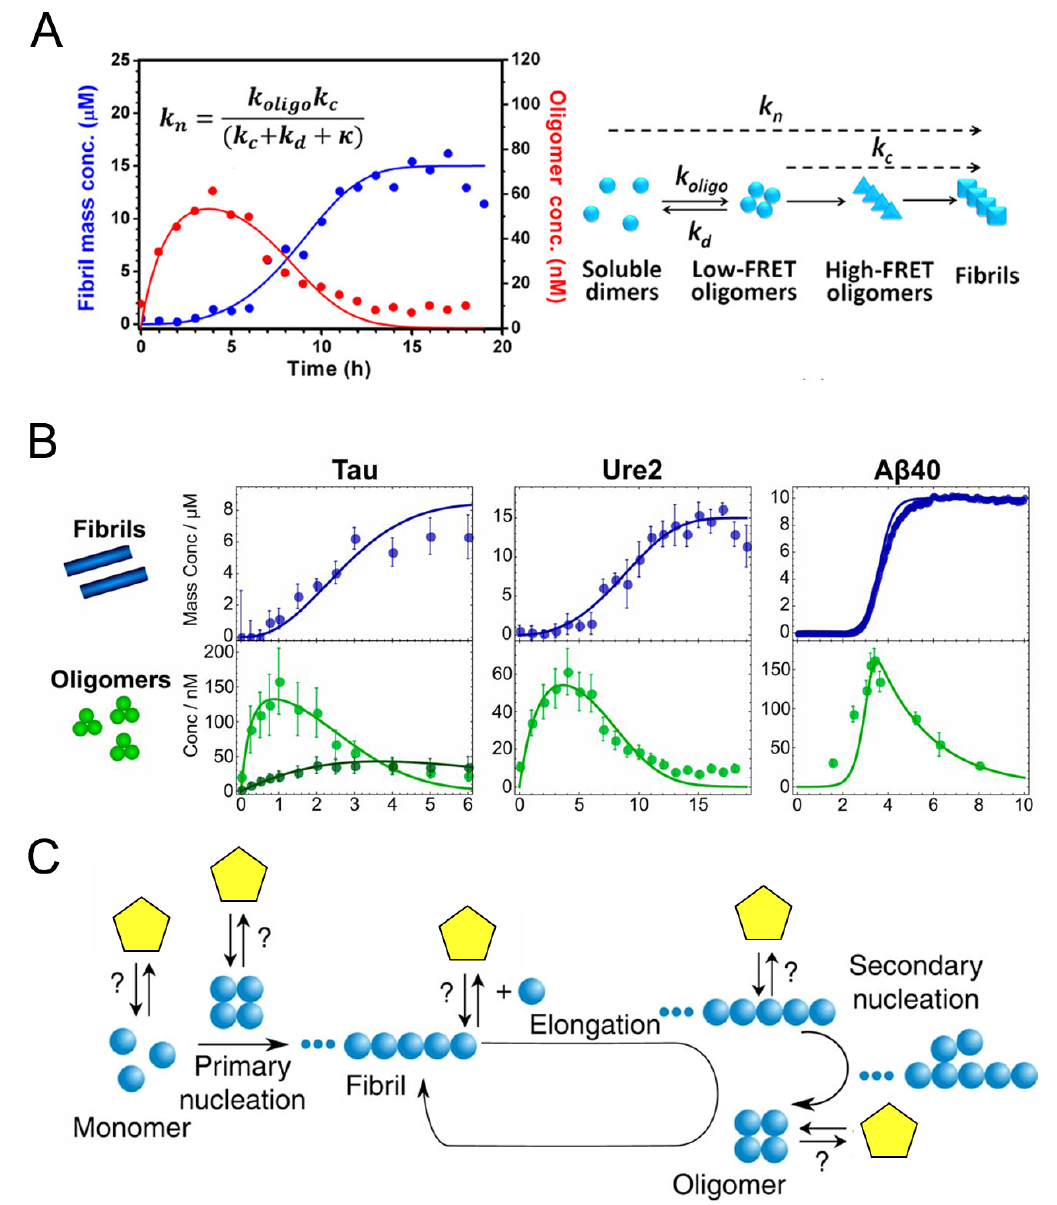
Figure 3. Kinetic analysis of amyloid aggregation. ( A ) A detailed kinetic model considering oligomer formation, dissociation, conformational conversion, fibril elongation and fragmentation is applied to describe the oligomerization measured by smFRET (red) and fibrillization measured by ThT (blue) globally. Figure reproduced from ref. [57] with permission. (Further permissions related to this part of the figure should be directed to the ACS. Original figures at: https://pubs.acs.org/doi/10 .1021/jacs.7b10439, accessed on 29 December 2020). ( B ) Global fitting of ThT (blue) and smFRET (green) data from different amyloid aggregation systems. Figure reproduced from ref. [105] with permission. ( C ) The possible effects of different factors (yellow symbols) on the microscopic mechanisms during amyloid aggregation. Figure adapted from ref. [106] with